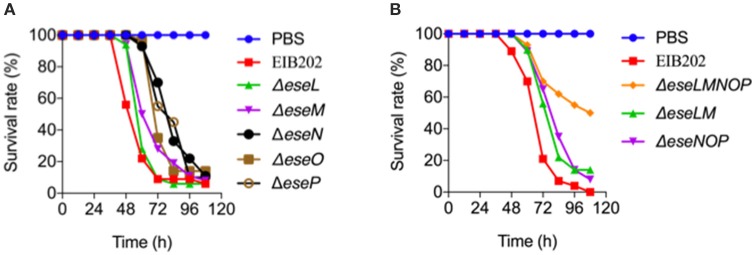
Survival of zebrafish infected with the indicated candidate effector mutants of Edwardsiella piscicida. Zebrafish were intramuscularly injected with wild-type E. piscicida EIB202, ΔeseL, ΔeseM, ΔeseN, ΔeseO, ΔeseP
(A), or ΔeseLM, ΔeseNOP, ΔeseLMNOP
(B) at 180 CFU per fish. PBS was used as a control. The survival of zebrafish was determined 4 days after injection, n = 35 fish per group.